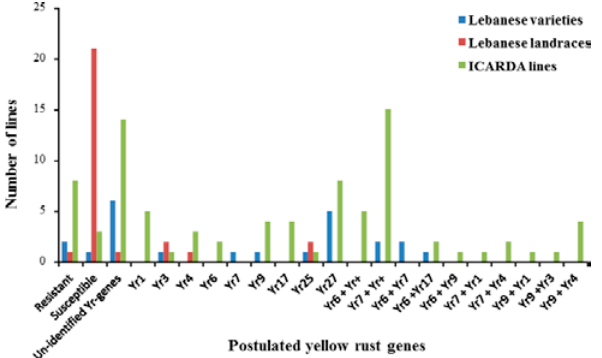
Figure 1. Postulated Yr seedling-stage stripe rust resistance in Leba- nese wheat varieties, Lebanese wheat landraces and ICARDA wheat